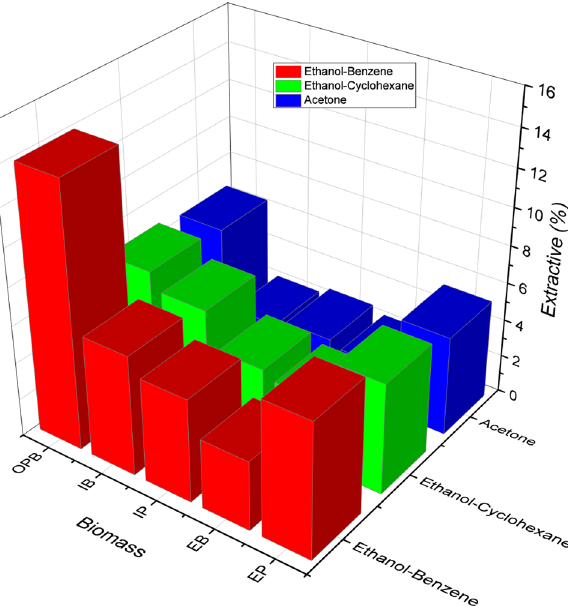
Figure 2. Pre-treatment of biomass with different solvent-mixtures (acetone, ethanol–benzene and ethanol- cyclohexane).